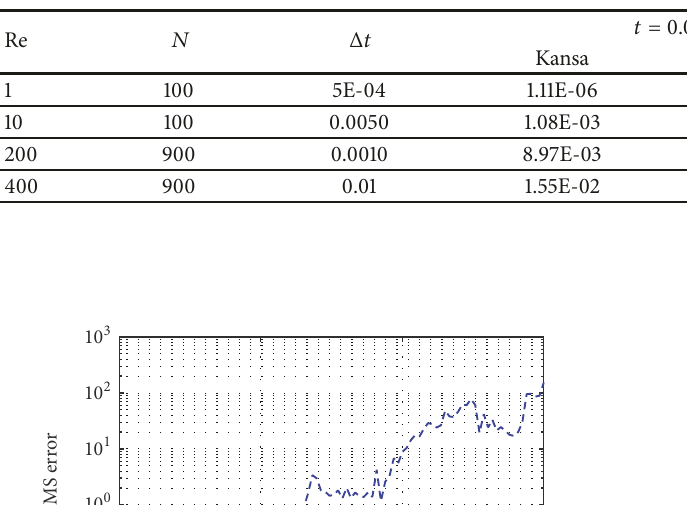
Table 2: Averaged 𝐿 𝑟𝑚𝑠 -error obtained with 𝑁 = 100 and 𝜀 = 0.001 for low to moderate Reynolds number.